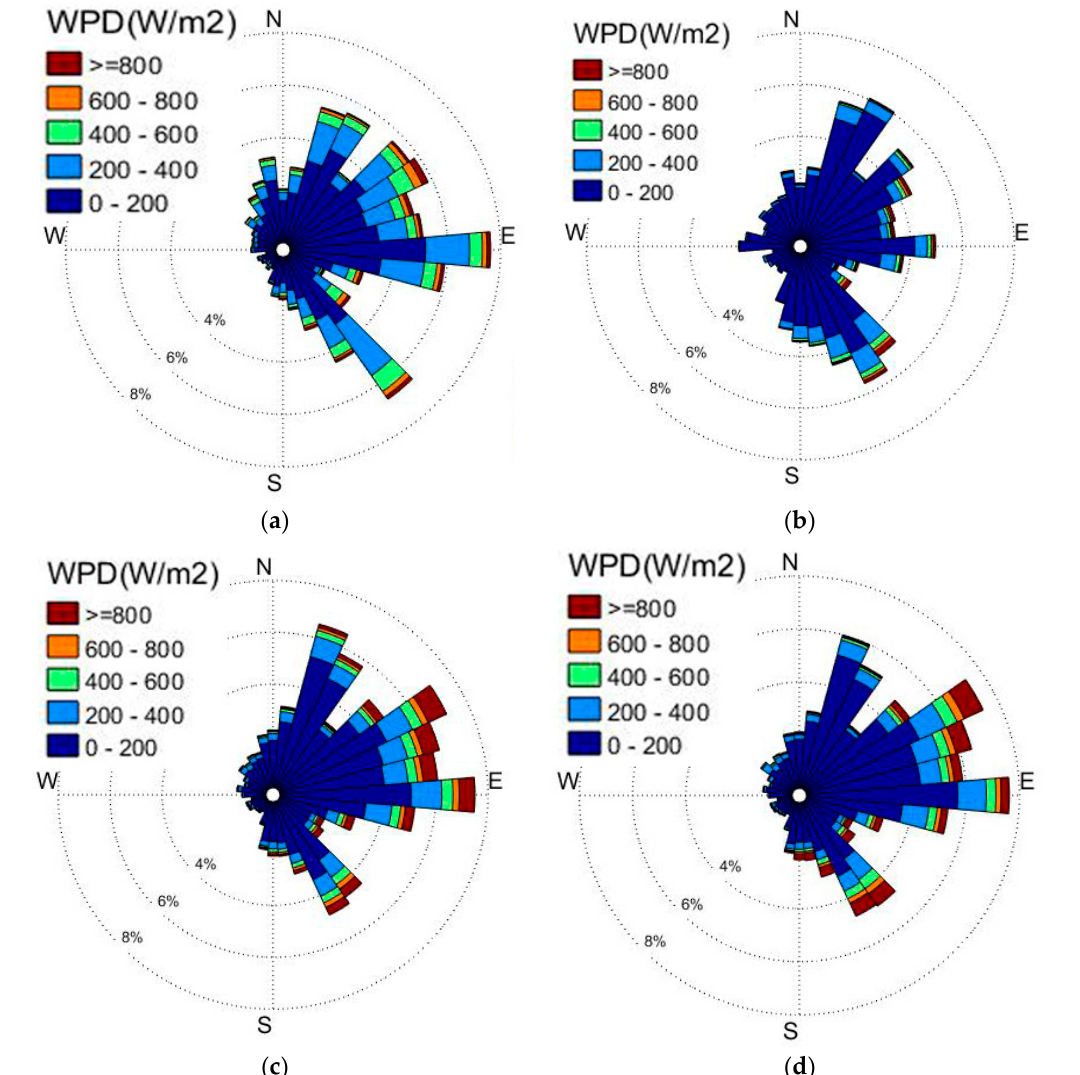
Figure 10. Observed wind power density (WPD) rose diagrams: ( a ) spring; ( b ) summer; ( c ) autumn; ( d ) winter.